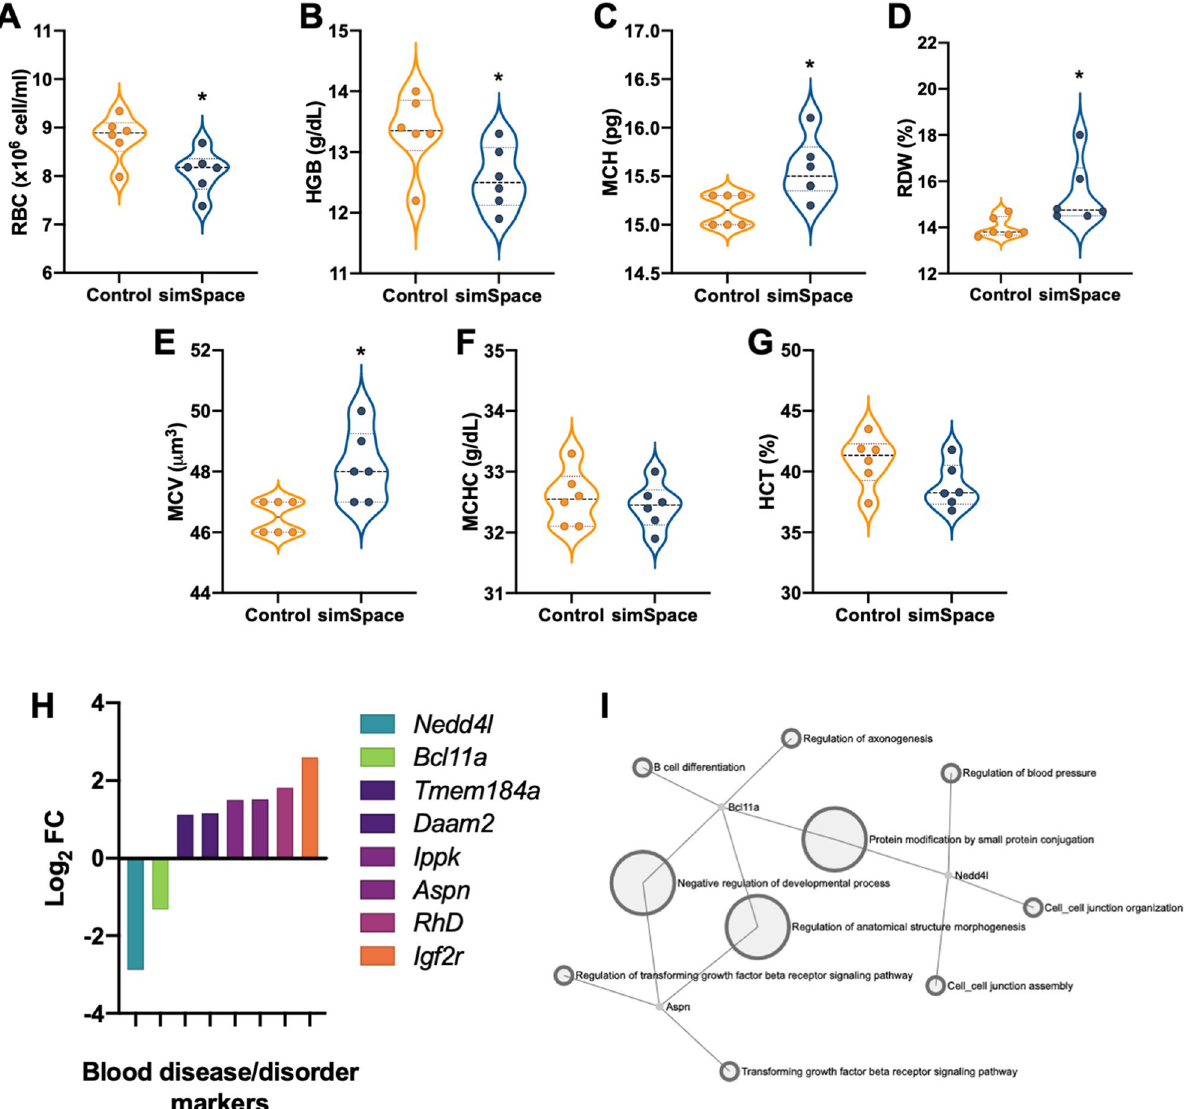
Figure 5. Distinct hematological gene expressions in spleens and red blood cell distributions in circulating blood post-simulated spaceflight. Whole blood was collected and red blood cell, RBC, × 10 6 per mm 3 ( A ), hemoglobin, HGB, g/dL ( B ), mean corpuscular hemoglobin, MCH, pg ( C ), mean corpuscular hemoglobin concentration, MCHC, g/dL ( D ), hematocrit, HCT, % ( E ), RBC distribution width, RDW, % ( F ), and mean corpuscular volume, MCV, fL ( G ). ( H ) Human blood disease/disorders as per Malacards Human Disease Databases (cite) displays human orthologs to mouse DEG. ( I ) Network Analyst Global EnrichNetwork tool mapped blood disease/disorder genes that shared common pathways. Cell numbers were normalized to controls. Data represents ± SEM, n = 6 per group. An unpaired, parametric t test with Welch’s correction was performed for ( A – G ), * p <